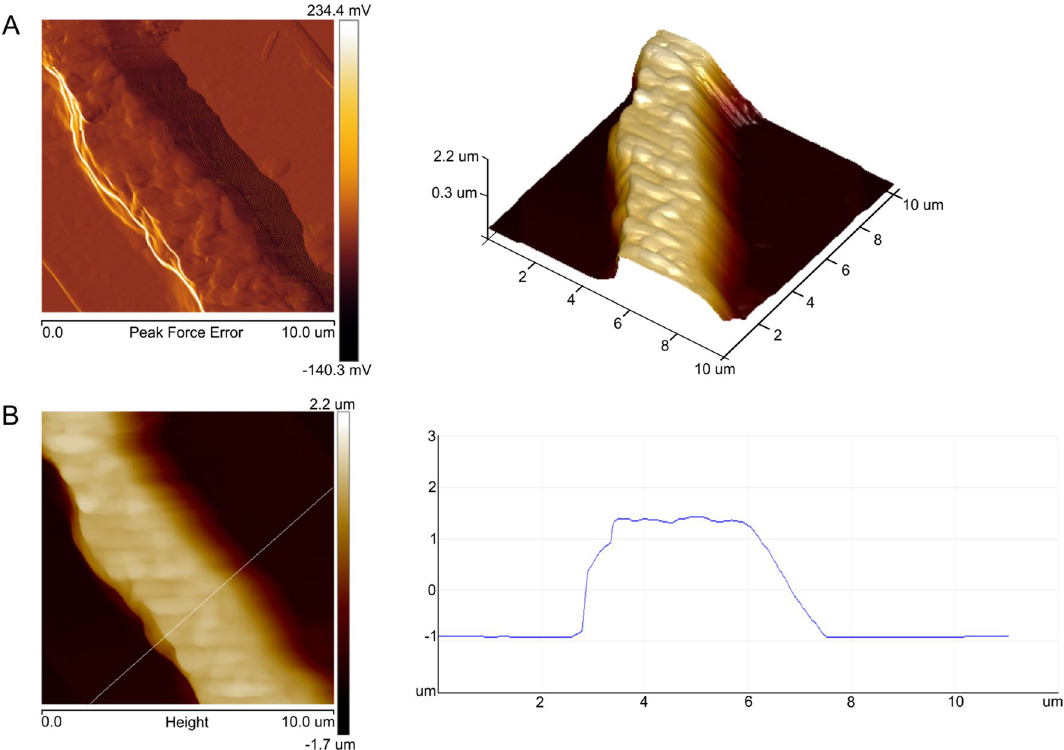
Figure 6. AFM images of fixed A. nordenskioeldii cells from Upper Foxfonna Glacier (elevation 789 m), A— peak force error images of a fragment of the fungal cell surface, 3D image—right panel; B—height image of the algal cell surface; the height profile is presented in the right